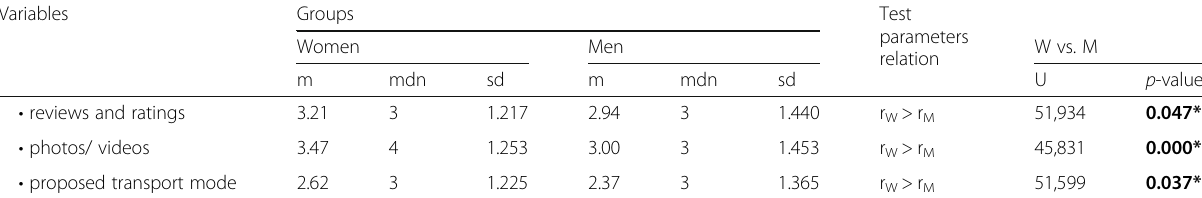
Table 6 Influence of social media content on women ’ s and men ’ s decisions Variables Groups Test